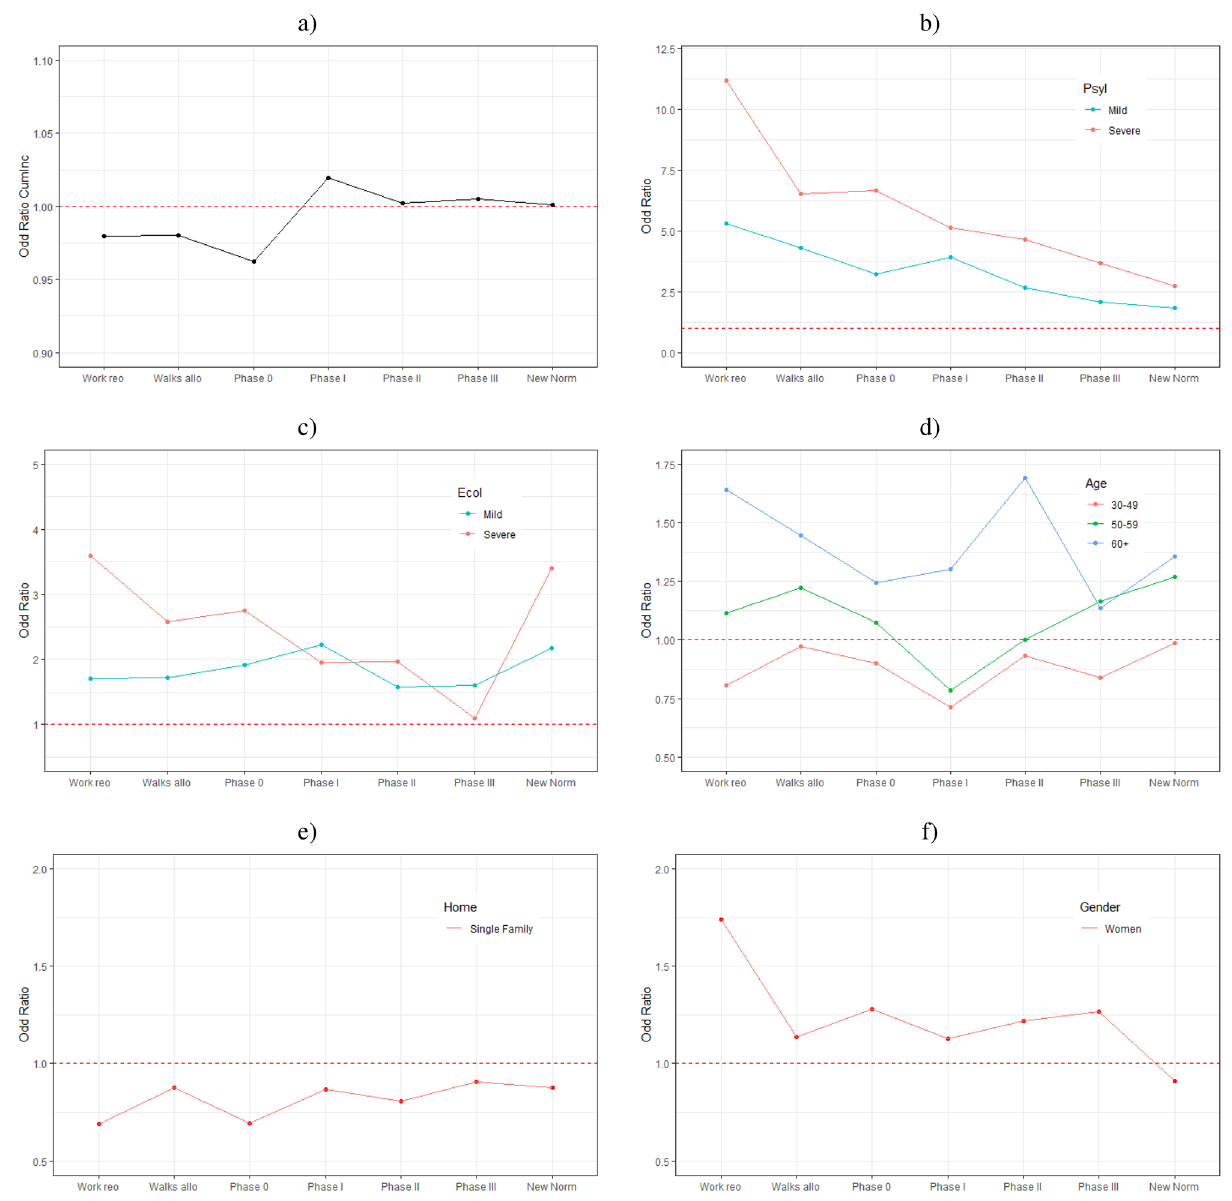
Figure 3. Odds ratios for the main variables of the models per phase. ( a ) CumInc ( b ) Psychological Impact, ( c ) Economic Impact, ( d ) Age, ( e ) Type of Home and ( f ) Gender. Each point on the X axis corresponds to the OR of the logistic model for that particular